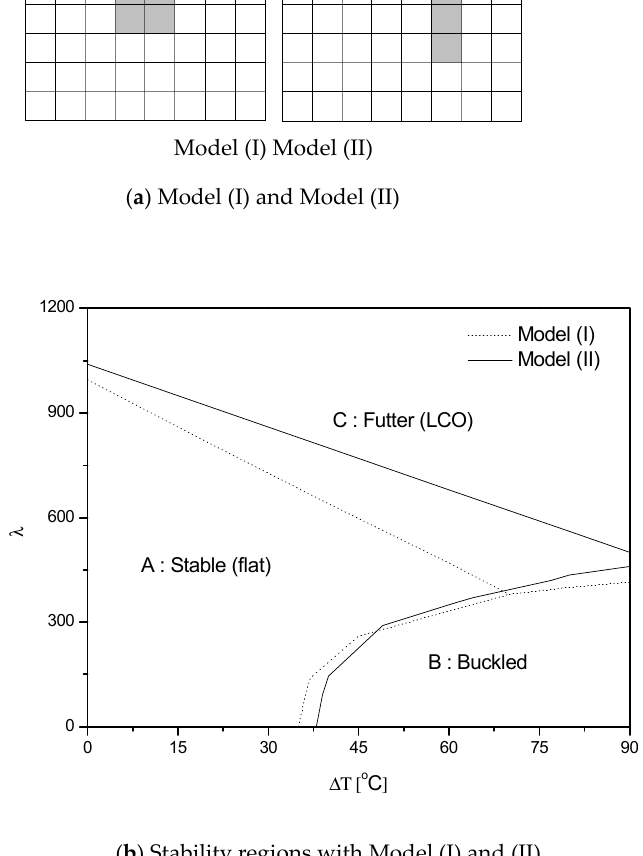
Figure 8. Stability regions according to the positions sensor/actuator pairs.